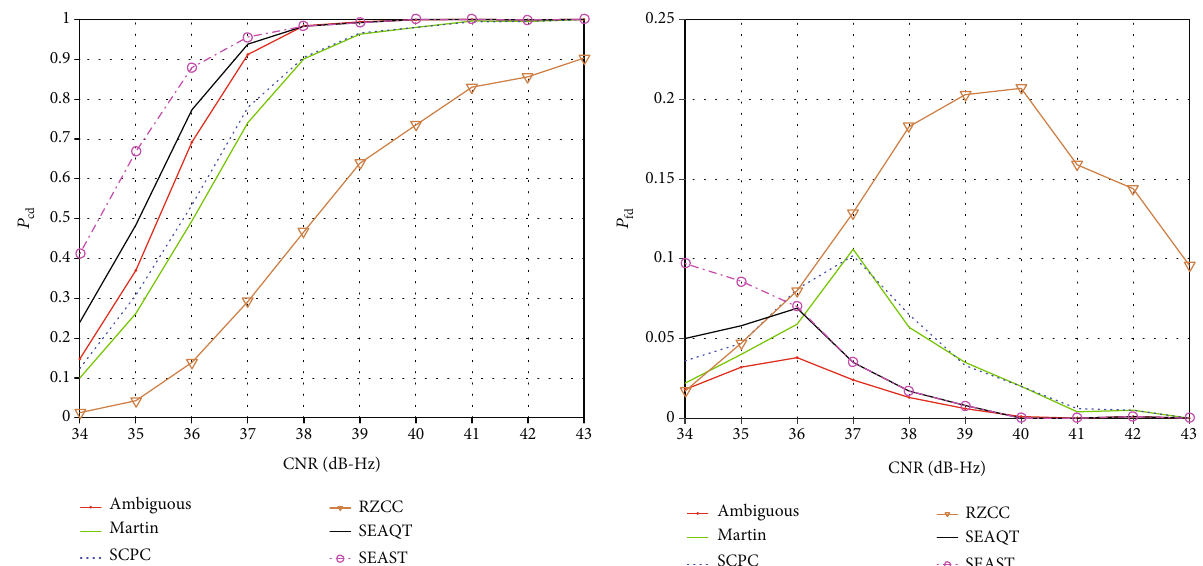
Figure 15: Correct detection probability and false detection probability for sin-BOC (10,